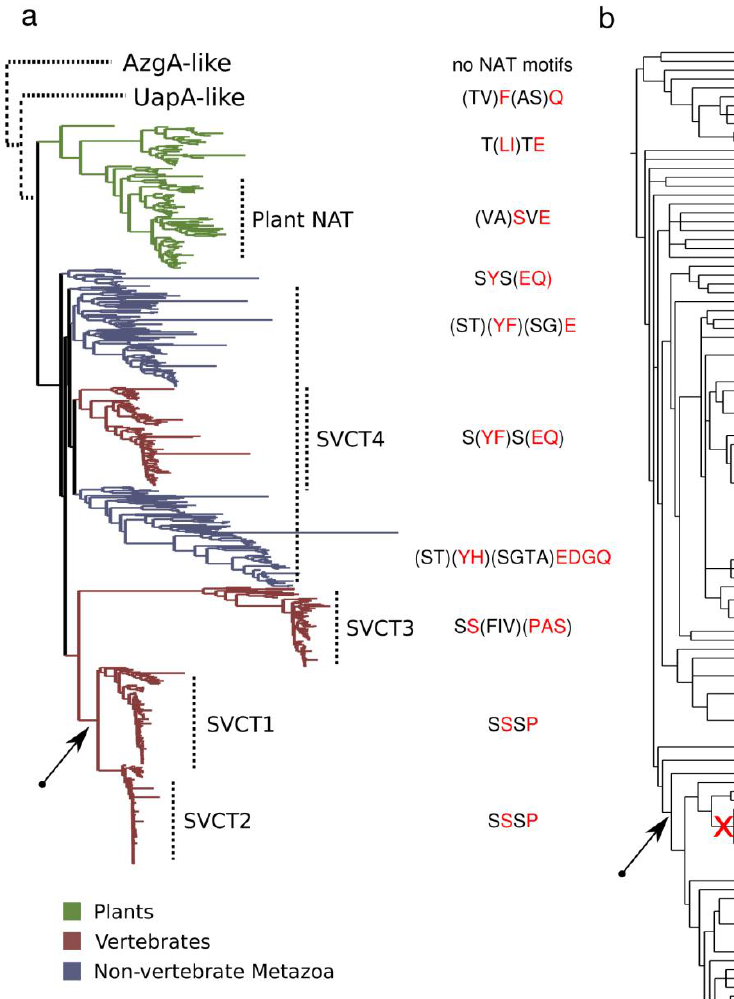
FIGURE 1: Evolution of the SVCT clade in NATs. (a) ML phylogenetic tree of the SVCT clade of NATs and the distinct NAT signature motifs. The dif- ferent SVCT plant and animal NAT subfamilies, as well as a variable con- sensus of the four first amino acids in the NAT signature motif, are indi- cated next to the tree. The tree was midpoint rooted, as shown, and the other two clades, UapA-like and AzgA-like, are placed schematically above with dotted lines. The UapA-like group corresponds to canonical microbial NATs and is shown in more detail in Supplementary Figure S1. The AzgA- group is used as an out-group of structurally homologous proteins, which however do not conserve the functional motifs of canonical NATs. For the complete version of the plant and animal NATs see also Supplementary Figure S2. (b) Phylogenetic profile of the SVCT clade sub-families for the 171 plant and animal species. The frequency of members in each subfami- ly is shown next to the NCBI taxonomy tree structure of the 171 species that were searched for NAT domains. The sub-families were defined based on (a) and in reference to the known mammalian transporters (SVCT1-4). Two early losses in two lineages, the SVCT3 in the Teleostean clade Euryp- terygii and SVCT4 in the primate suborder Haplorhini, are indicated in the corresponding branches with a red “x”. The emergence of the L-ascorbic acid transport specificity is indicated with a black arrow both in the phylo- genetic tree (a), as well as in the taxonomy tree (b). The colors (green, red, blue) in both (a) and (b) are as indicated in the figure legend. Both trees were visualized using the ETE toolkit